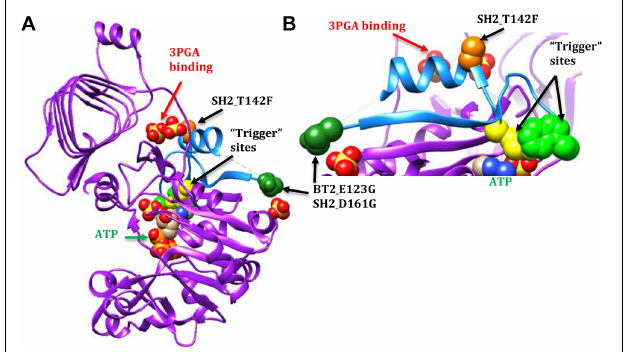
FIGURE 3 | AGPase crystal structure diagrams with part of the Rossmann-like motif shown in light blue. A dashed line occurs between the dark green spheres and the blue a-helix because the amino acids in this area were too mobile to map in the potato crystal structure. In this particular subunit, nine amino acids are missing. The active site is indicated by the ATP (green text and arrow). The activator site is indicated by the two sulfates below the GaG motif (red text and arrow). The BT2 and SH2 amino acid sites of interest are represented by colored spheres: BT2.E123G/SH2 D161G (dark green spheres) and SH2.T142F (light orange spheres). The spheres are amino acids in the potato crystal structure. The E. coli “trigger” sites are represented by yellow spheres (Q74 or SH2_Q138) and light green spheres (W113 or SH2.W179). (A) A single subunit viewed from the inside of the